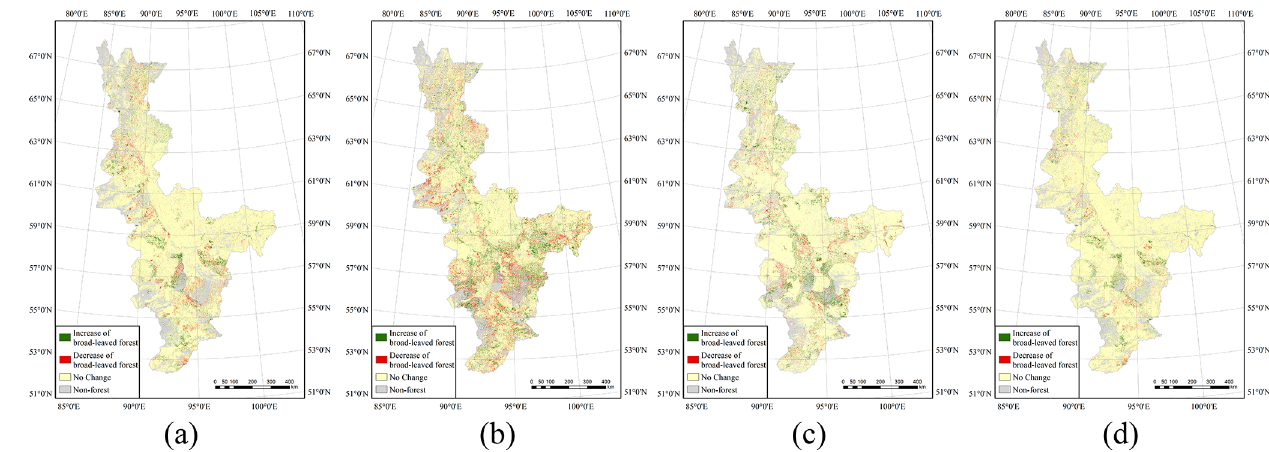
Figure 7. Changes in broad-leaved forest area for (a) 1985–1995, (b) 1995–2005, (c) 2005–2015 and (d) 1985–2015.